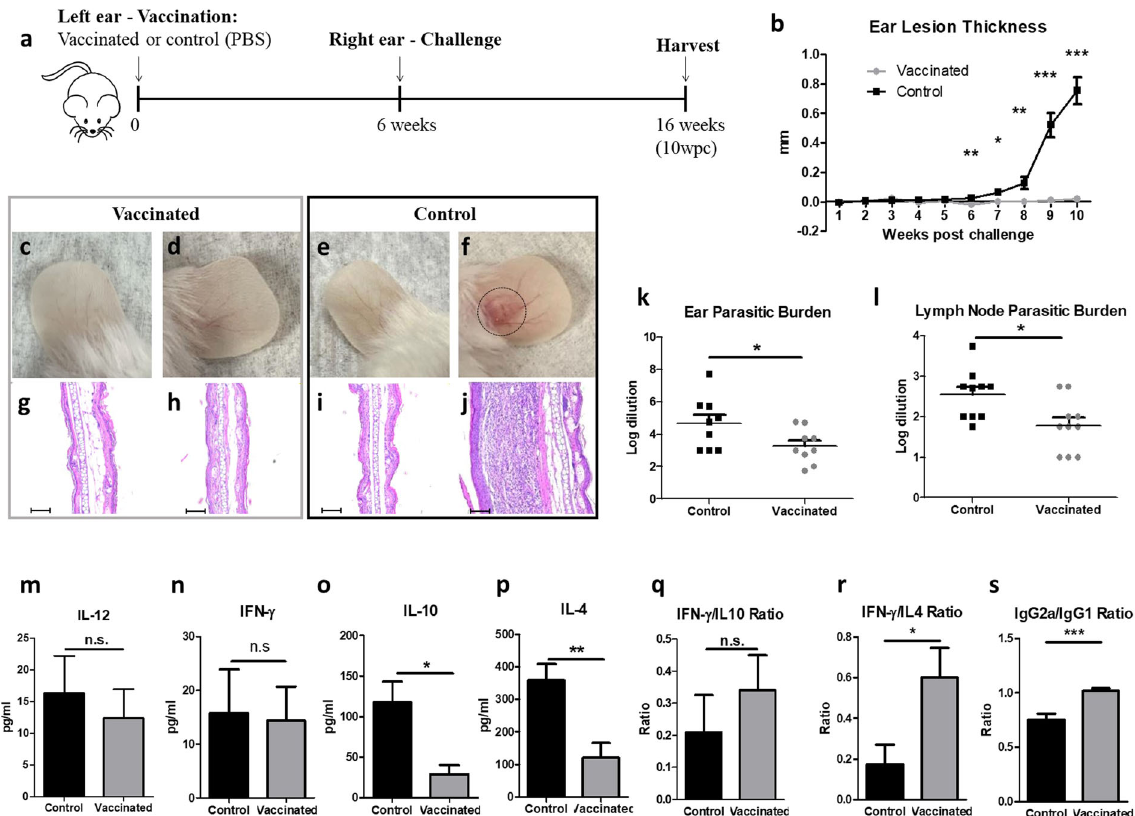
Fig. 6 LmexCen − / − immunization mediates protection against challenge with Lmex WT in BALB/c mice. a Schematic of the vaccination study design for BALB/c mice. b Ear lesion thickness of vaccinated and control mice measured for 10 wpc. c – f Representative vaccinated ear ( c ), challenged ear of vaccinated mouse ( d ), PBS-inoculated ear of control mouse ( e ), and challenged ear of control mouse ( f ) at 10 wpc. g – j H&E staining of cross-section of representative vaccinated ear ( g ), challenged ear of vaccinated mouse ( h ), PBS-inoculated ear of control mouse ( i ), and challenged ear of control mouse ( j ) at 10 wpc. Scale bar for g – j : 100,000 μ m. k , l Parasitic burdens in the ear ( k ) and draining lymph nodes ( l ) at 10 wpc. m – p Cytokine levels of IL-12 ( m ), IFN- γ ( n ), IL-10 ( o ), and IL-4 ( p ) in the lymph nodes of vaccinated and control mice stimulated with L. mexicana antigen at 10 wpc. q , r Ratio between IFN- γ /IL-10 ( q ) and IFN- γ /IL-4 ( r ) levels in the lymph nodes of vaccinated and control mice at 10 wpc. s Ratio of log titers of IgG2a/IgG1 antibodies in the serum of vaccinated and control mice measured for 10 wpc